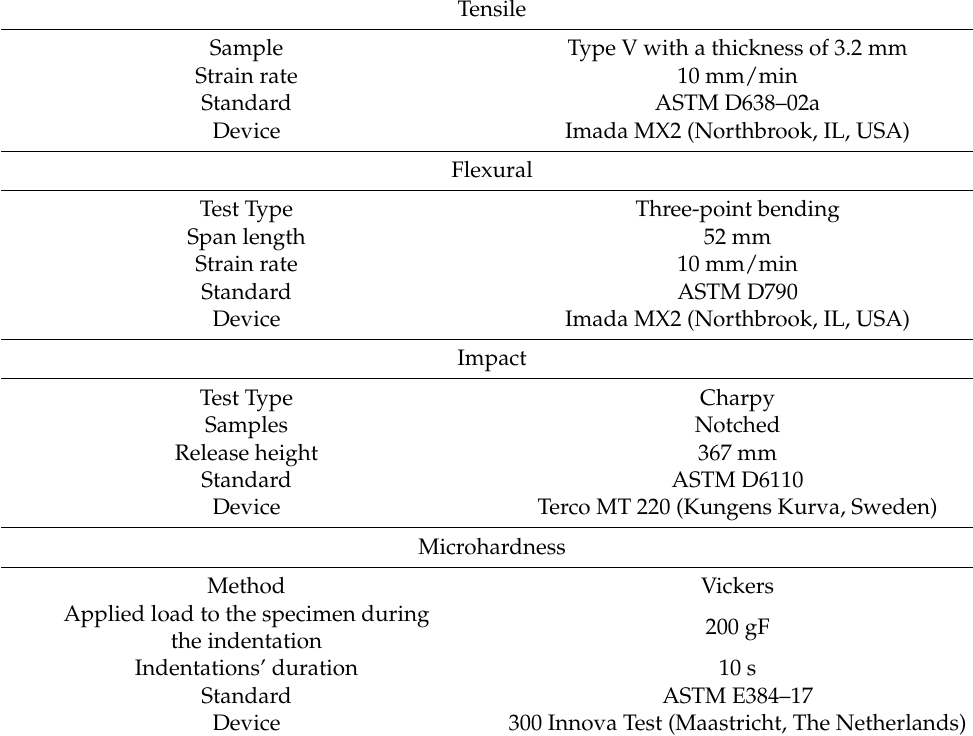
Table 1. Mechanical Characterization